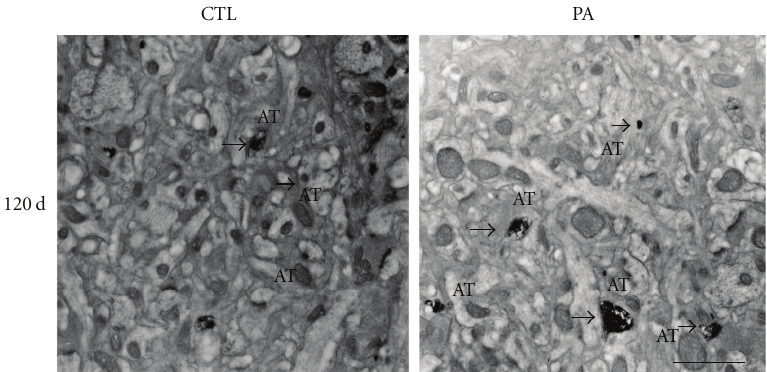
Figure 4: Electron micrographs of ubiquitin immunolabeling from Stratum radiatum of CA1 hippocampal tissue of 4-month-old control rats and rats subjected 19 min of PA. Strong ubiquitin stained was observed in asphyctic PSDs (arrowheads). In control animals ubiquitin staining was very weak and rare. AT: axon terminal. Scale bar: 0.5 μ m.